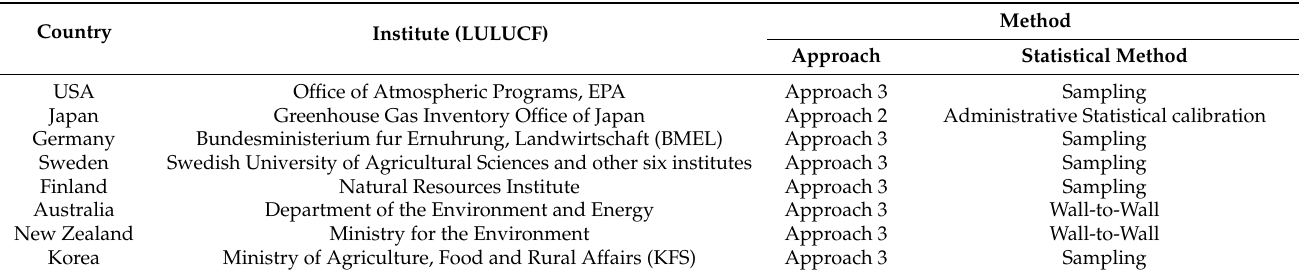
Table 1. Comparison of government agencies responsible for overseeing land use, land-use change, and forestry (LULUCF), and methods for land-use change matrix detection by